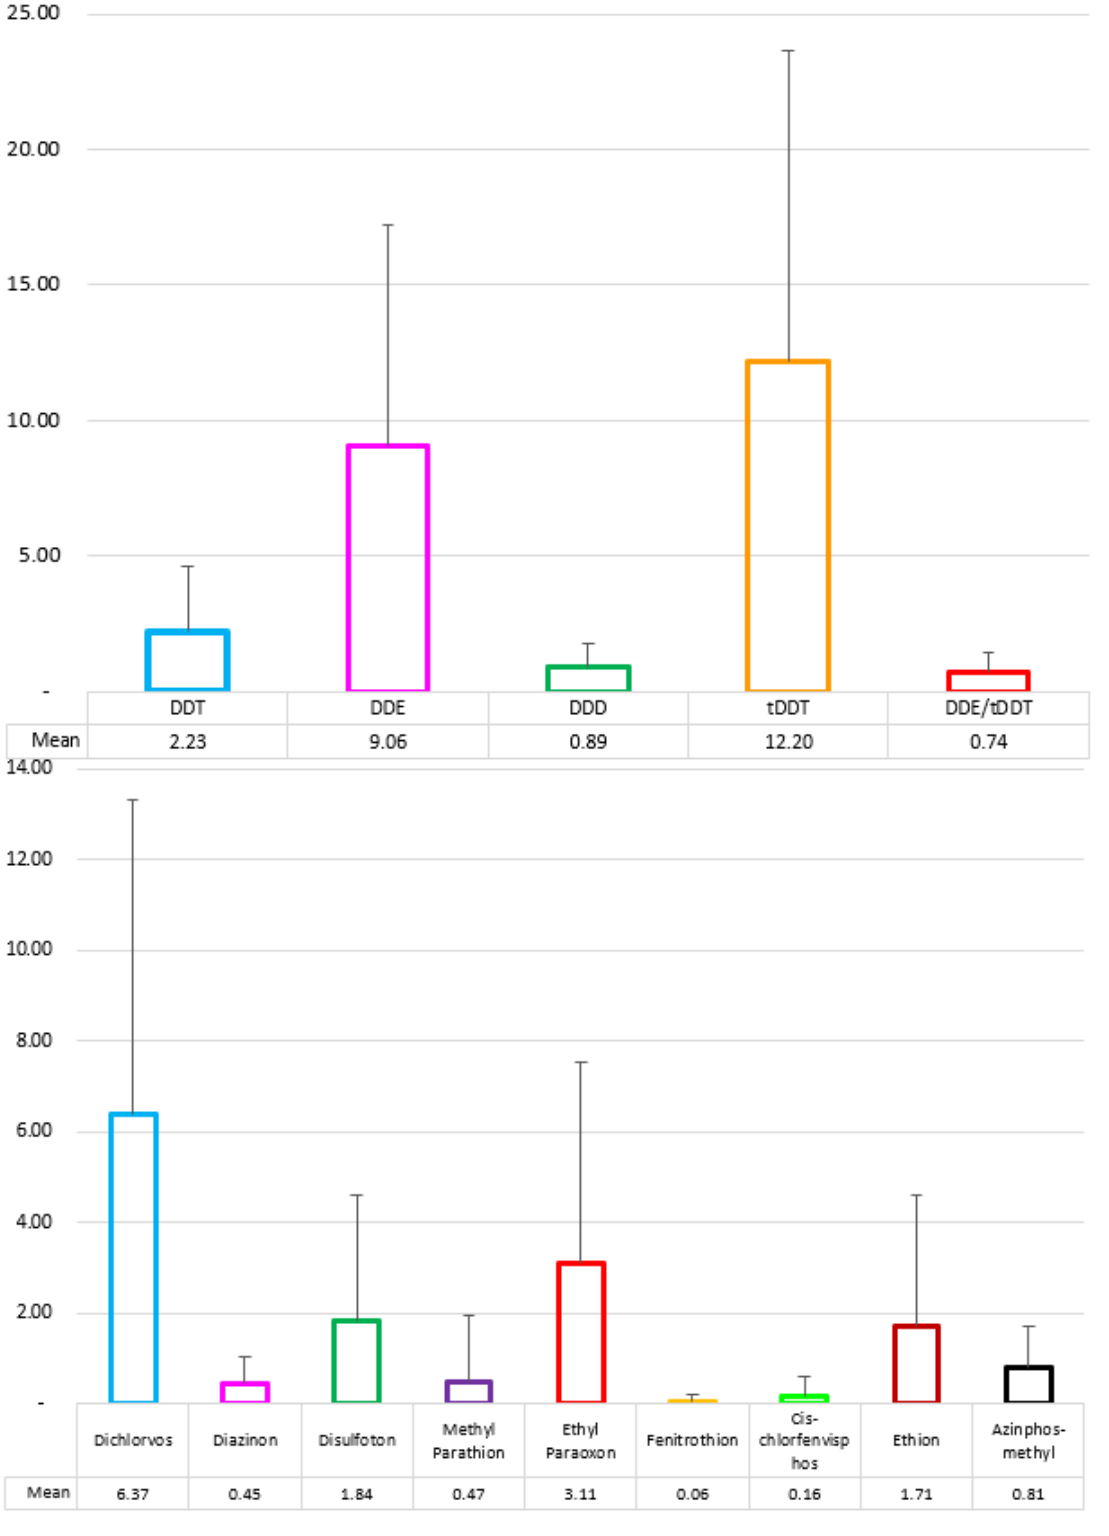
Figure 2. Average concentration on a lipid weight base of DDTs (ppm) and OPs (ppb) in the blubber of south-eastern Caspian seals. No other OCs were detected in the samples.